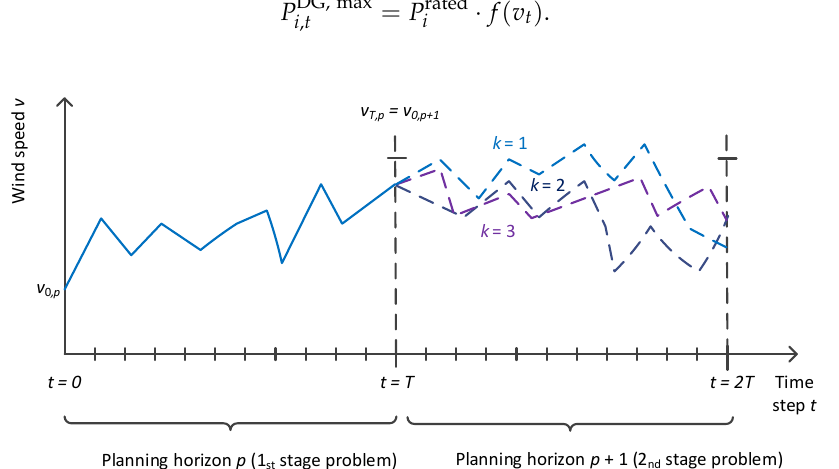
Figure 2. Schematic illustration of the model of stochasticity in wind speed beyond the planning horizon 𝑡 = 𝑇 .